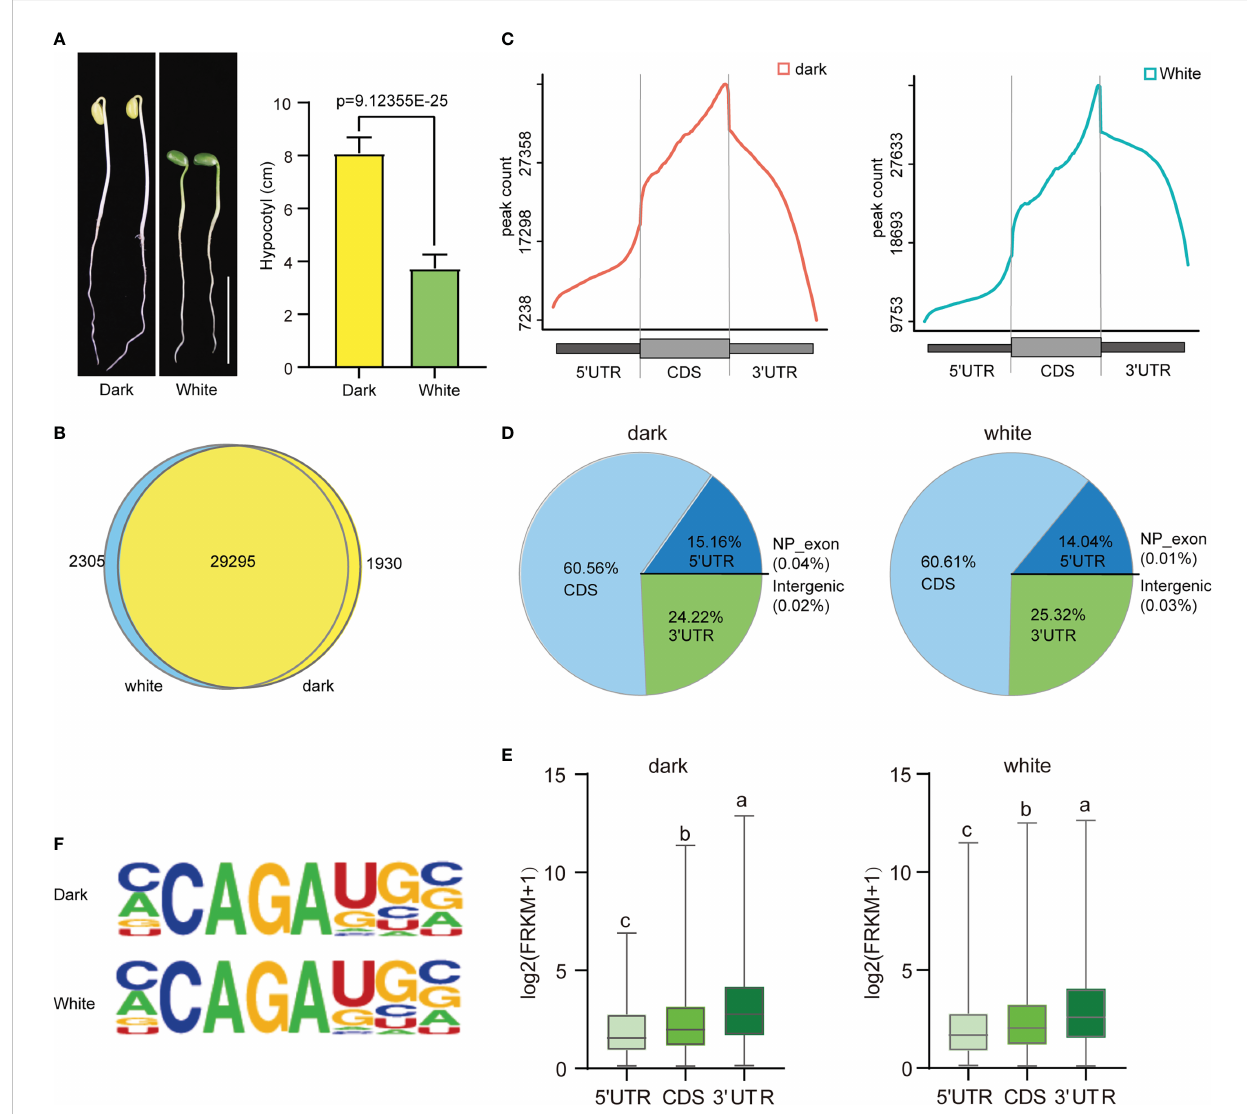
FIGURE 1 Overview of the m 6 A methylome in soybean. (A) The phenotype and hypocotyl statistics of Williams 82 grown in the dark and with continuous white light (100 m mol m -2 s -1 ) for 4 days. Scale bars correspond to 5 cm.The comparisons were performed using Student ’ s t-tests. Data are shown as means ± SD (n = 15). (B) Venn diagram showing the overlap of m 6 A peak-containing genes in two independent m 6 A-seq experiments for wild type plants grown under dark and continuous white light conditions. (C) Distribution of m 6 A peaks in transcript segments. (D) Pie charts showing the distribution of m 6 A peaks plants grown under dark and continuous white light conditions. (E) Gene expression (log2(FRKM+1)) of m 6 A peaks within three transcript segments. (F) Most representative motifs called for each group (dark and white light). The letters above the bars indicate signi fi cant differences (P < 0.05) as determined by one-way